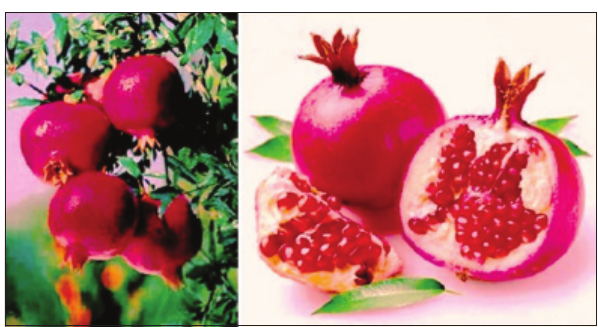
Figure-2: Punica granatum L.